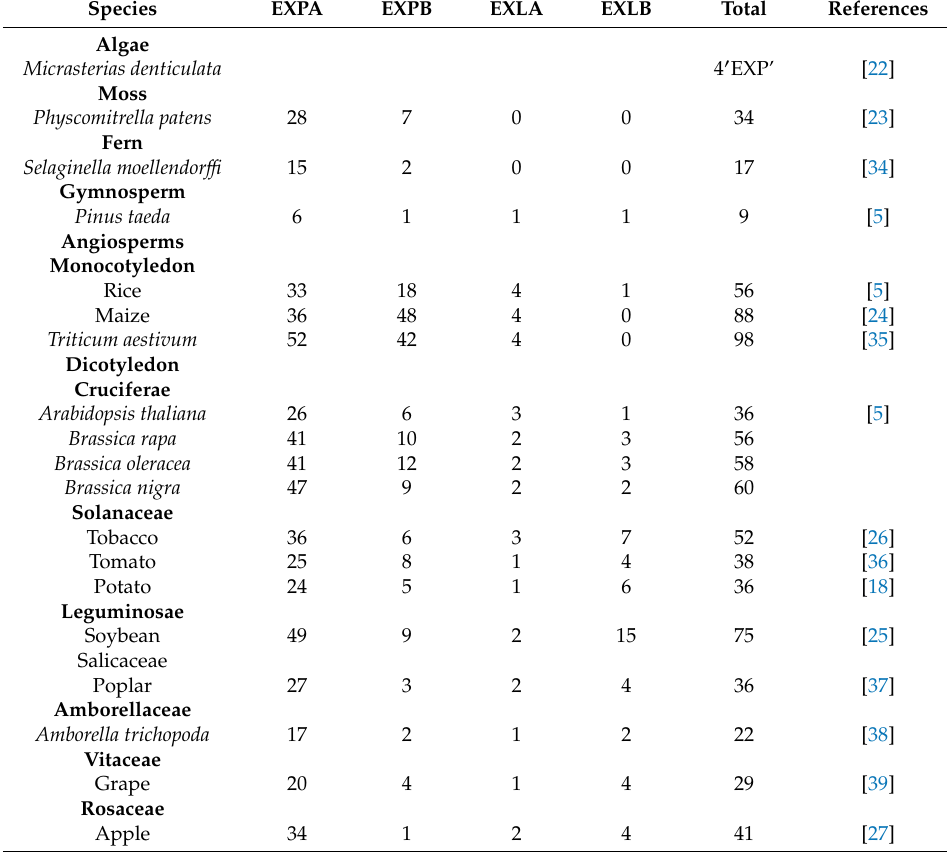
Table 1. Numbers of expansin genes in di ff erent